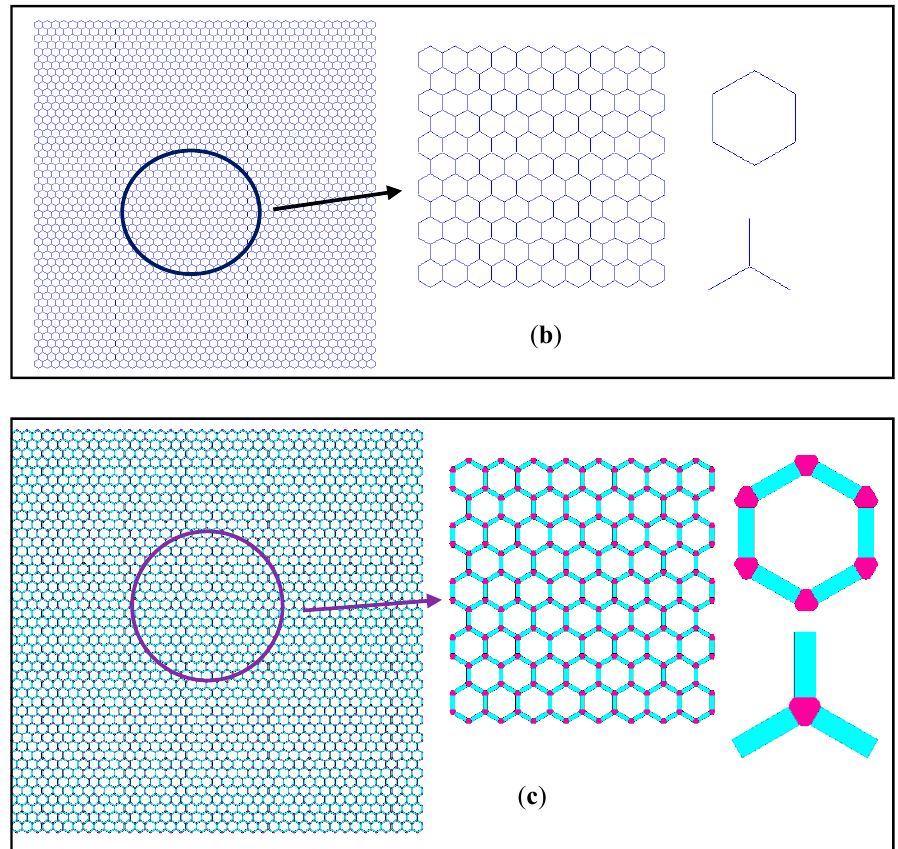
Figure 1. The geometrical configuration of the finite element model of graphene. ( a – c ) are the three-dimensional model, conventional two-dimensional model and proposed hybrid finite element model, respectively.